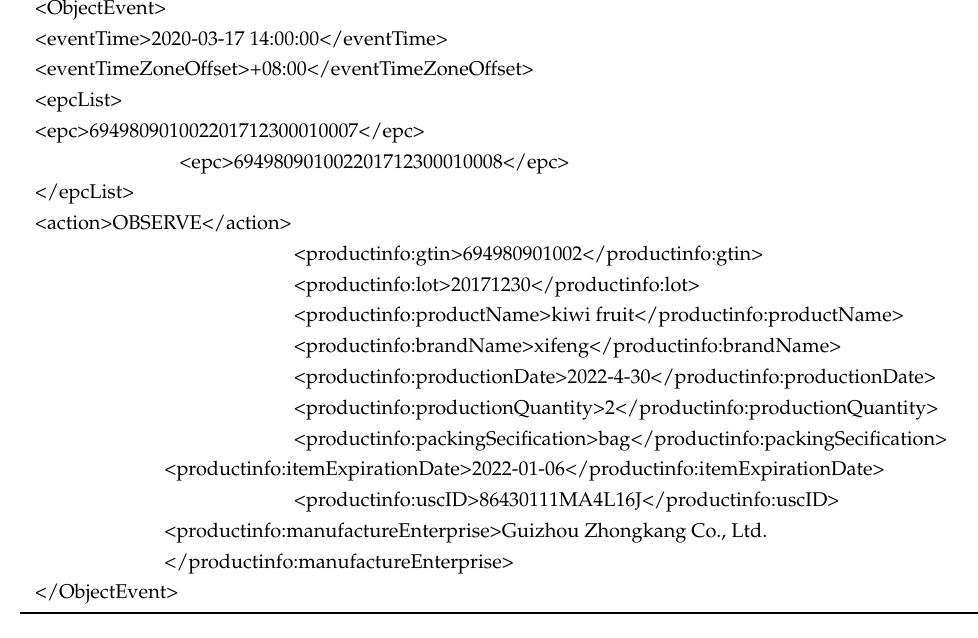
Table 4. EPCIS event data structure.